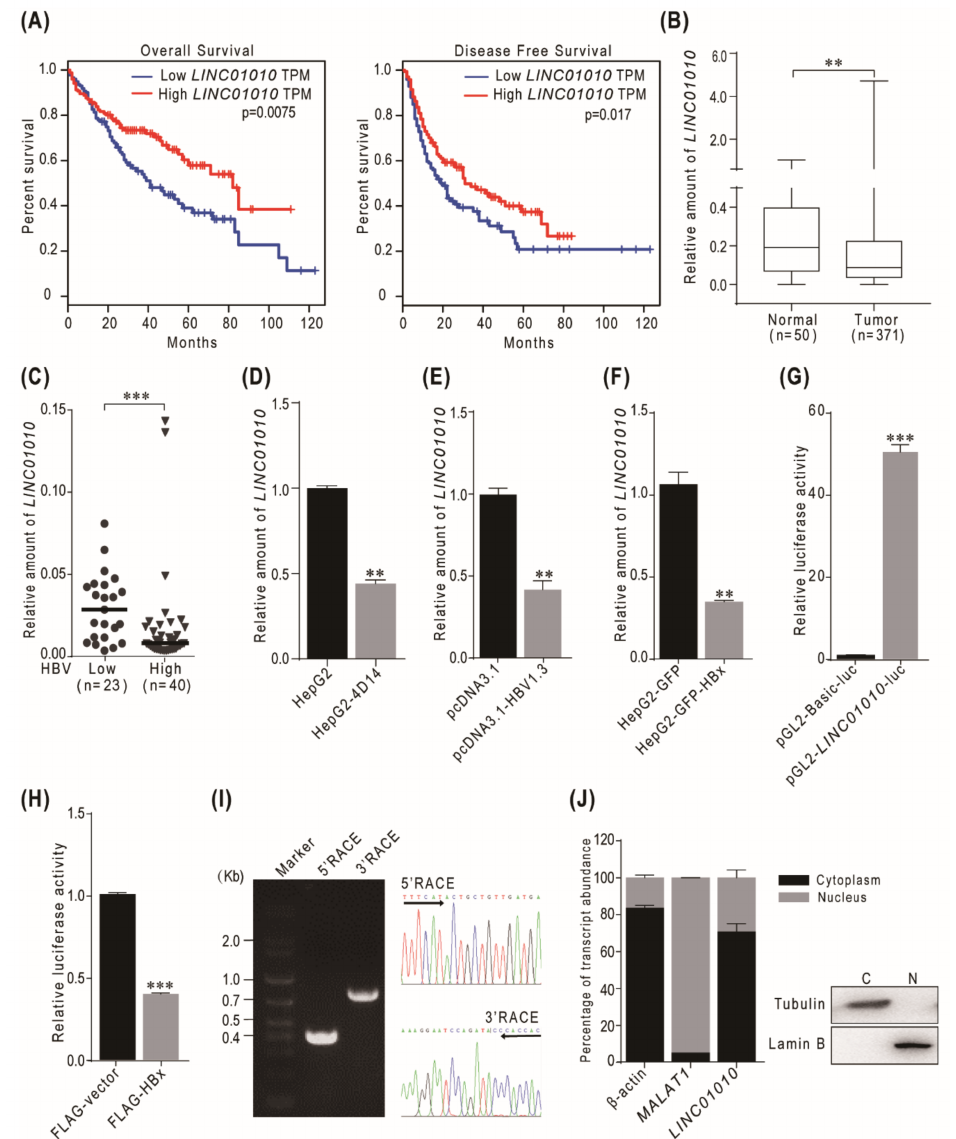
Figure 1. LINC01010 is an HBV-associated lncRNA and downregulated in HCC. ( A ) Kaplan–Meier analysis of overall survival (left) and disease-free survival (right) in patients derived from the TCGA-LIHC cohort based on LINC01010 levels. ( B ) LINC01010 levels in HCC tumor tissues ( n = 371) and normal tissues ( n = 50) in TCGA-LIHC cohort. ( C ) The relative levels of LINC01010 in 63 HCC samples were determined by real-time PCR. The samples were divided into two cohorts according to HBV copies in serum (low: n = 23, less than 40 copies/mL; high: n = 40, more than 40 copies/mL). ( D ) Relative levels of LINC01010 in HepG2 and HepG2-4D14 cells were determined by real-time PCR and normalized with GAPDH as an internal control. ( E ) L02 cells were transfected with pcDNA3.1 or pcDNA3.1-HBV1.3 for 72 h. Total RNA was extracted, and the levels of LINC01010 were determined by real-time PCR. ( F ) The amount of LINC01010 in HepG2-GFP and HepG2-GFP-HBx stable cell lines was determined by real-time PCR and normalized with GAPDH as an internal control. ( G ) pGL2- LINC01010 -luc was transfected into 293T cells, and luciferase reporter assay was performed after 48 h with pGL2-basic luciferase as control. ( H ) 293T cells were co-transfected with pGL2- LINC01010 -luc and pCMV FLAG-HBx or pCMV FLAG-vector for 48 h. The cell lysates were collected and subjected to luciferase assays. ( I ) Total RNA was extracted from HepG2 cells and subjected to 5 (cid:48) and 3 (cid:48) RACE assays for full length of LINC01010 . The RACE PCR products of LINC01010 (left) and sequencing data (right) are shown. ( J ) The total RNA was extracted from cytoplasmic (C) and nuclear (N) fractions in HepG2 cells and subjected to real-time PCR to quantify LINC01010 using MALAT1 and β -actin as controls. The fractionated lysates were immunoblotted with tubulin and lamin B. ** p < 0.01 and *** p < 0.001, means ± SD are